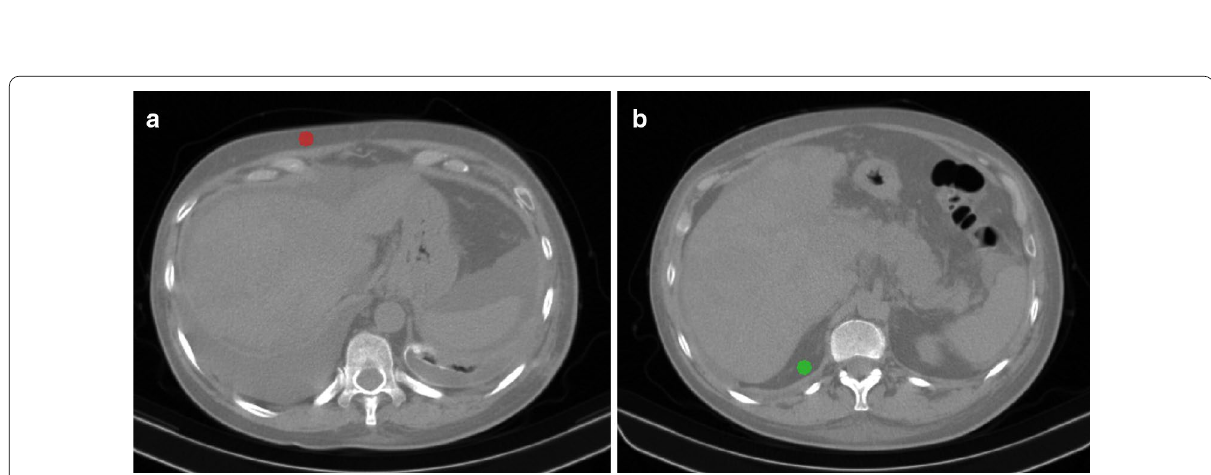
Fig. 2 Segmentation of: a subcutaneous adipose tissue and ( b ) visceral adipose tissue by placement of round regions of interest with a 15 mm